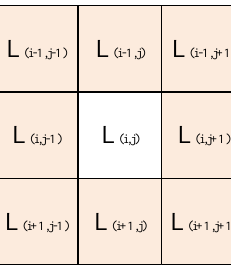
Figure 8. Class labels of the central pixel and its eight neighborhood pixels.